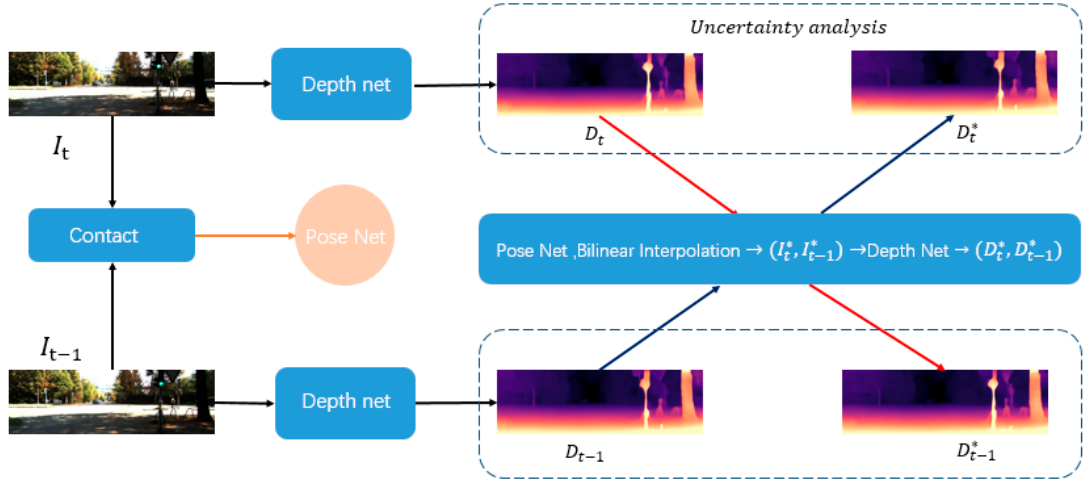
Figure 1. Monocular depth estimation network structure (all depth maps in the figure have pixel-level depth, which is absolute depth.)